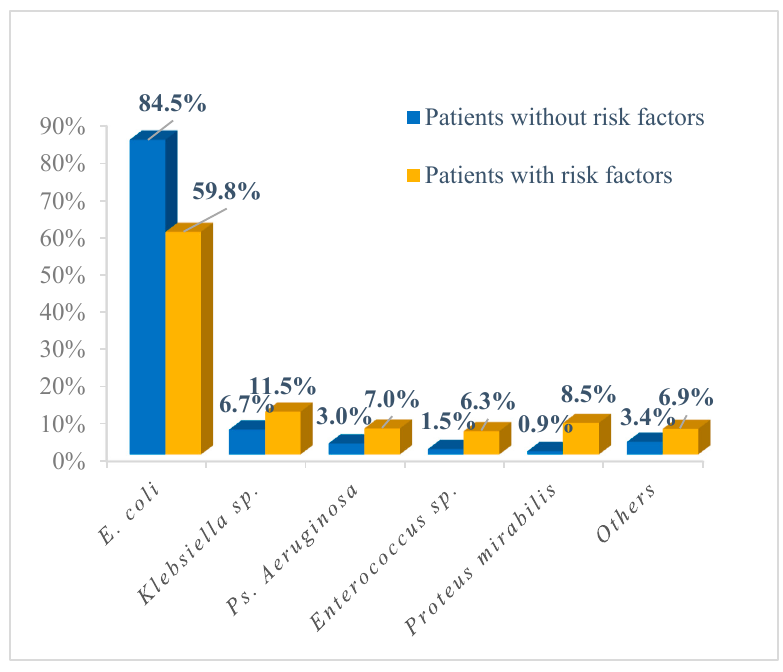
Figure 5. Etiology of UTIs in children with and without risk factors.